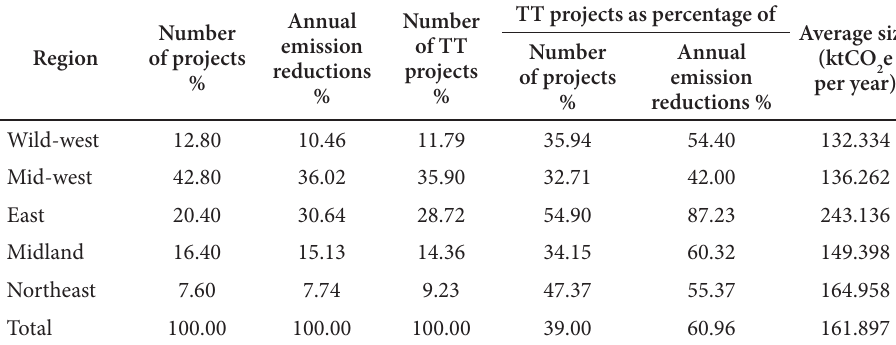
Table 5. Host region